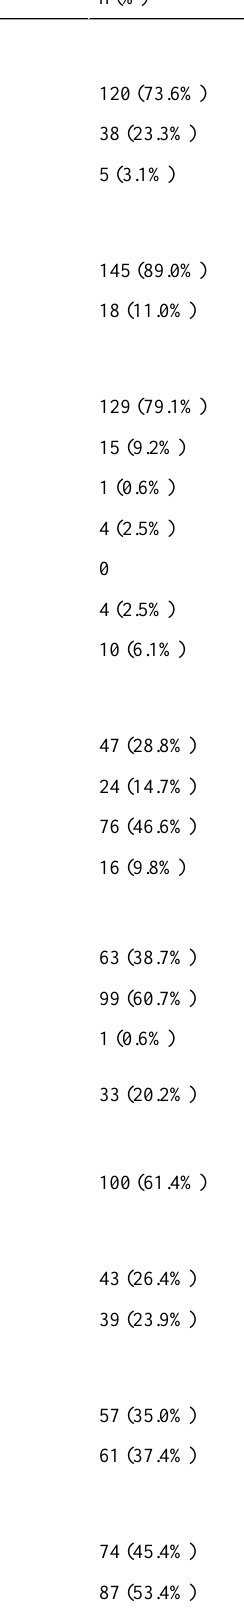
Table 1. Sample characteristics and demographics of physician respondents to both the 2005 and the 2009 Massachusetts eHealth Collaborative (MAeHC) surveys (n = 163).